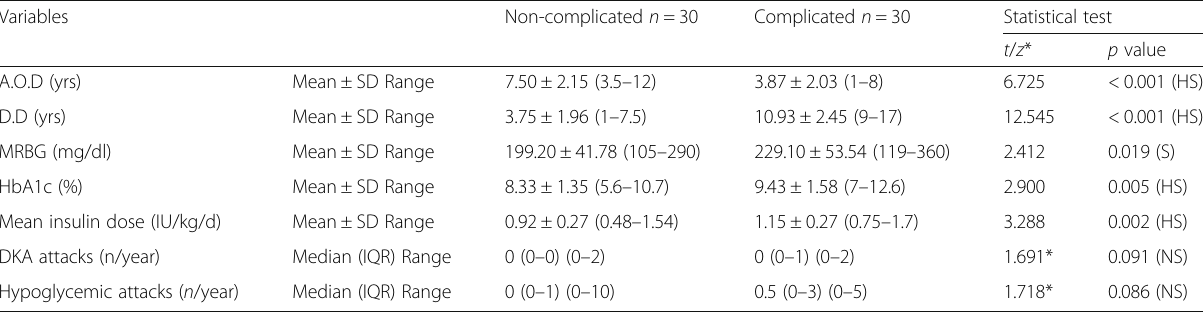
Table 2 Comparison between the two studied diabetic (non-complicated and complicated) groups in terms of their metabolic control